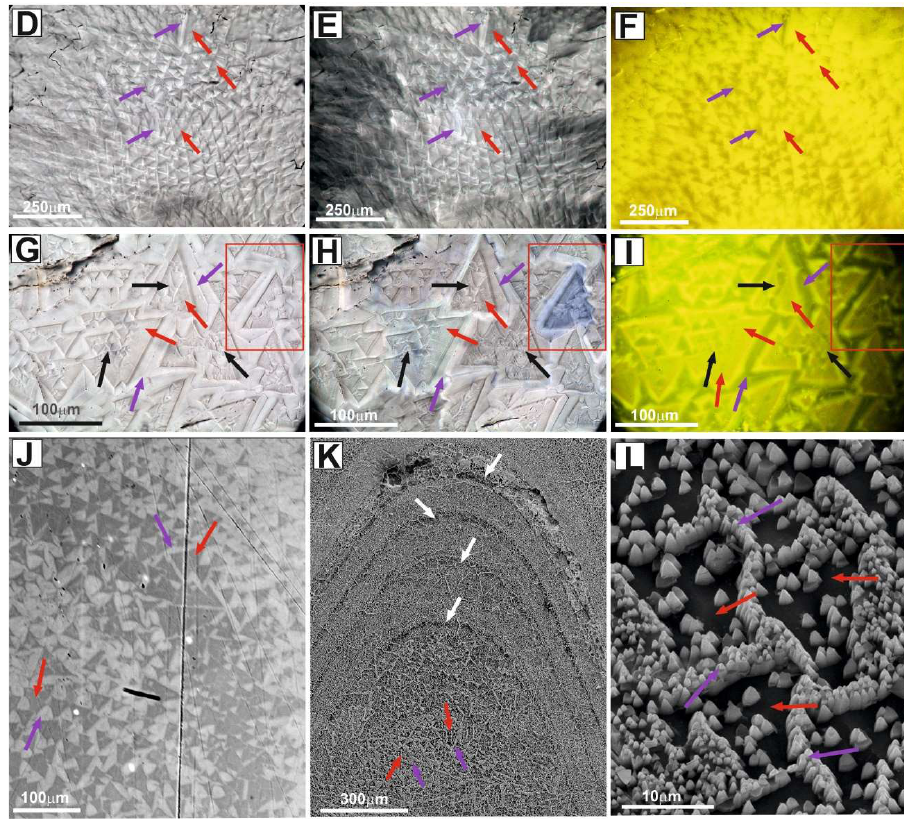
Figure 9. Photographs showing the composite nature of calcite crystals in belemnite rostra, which is observed in longitudinal sections that do not cross-cut the rostrum along the apical line. ( A – C ) TL ( A ), PL ( B ) and FL ( C ) photographs (specimen PC 31-4). In the central area, calcite crystals are cut perpendicularly to their c-axis and they are observed as an equigranular mosaic of crystals. Outwards, towards the external wall, crystals are cut tangentially to their c-axis and become elongated. Note also that the concentric layering is enhanced under FL microscopy and that layers become thinner towards the external walls. ( D – F ) Detailed images of ( A – C ). Note the triangular shape of crystals that comprise sectors displaying relatively low optical relief ( D , E ) and intense FL ( F ) (red arrows) and sectors displaying relatively high optical relief ( D , E ) and none-to-weak FL ( F ) (purple arrows). ( G – I ) Detailed photographs showing the composite nature of calcite crystals under TL ( G ), PL ( H ) and FL ( I ) microscopy (specimen PC-11-31). Triangular-shaped crystals comprise an inner sector (red arrows), which displays an overall relatively low optical relief ( D , E ), intense FL ( F ) and an internal “patchy” appearance (black arrows). Note that the “patches” also displays a triangular shape and higher optical relief than the surrounding calcite. The outer sector of the crystals (purple arrows), which is in optical continuity with the inner sector (red square in ( H )), displays relatively high optical relief ( D , E ) and non-to weak FL ( F ). Note the crystal boundaries (purple arrows and red square in ( G ) and ( H )). Note also that the triangular “patches” of the inner sector has an identical optical relief and FL than the outer sector of the crystals. ( J ) Same thin section as in ( A – F ), observed under BSEM. The triangular inner sectors of the crystal displaying intense FL are dark-grey in colour (red arrows), and the outer sectors of the crystals, displaying non-to weak FL, are light-grey in colour (purple arrows). ( K , L ). Same thin section as in ( A – G ), observed under BSEM after etching with 25% glutardialdehyde. Note that the triangular shape of crystals and the concentric layering (white arrows in ( K )) is enhanced under etching. The triangular areas comprise an inner sector, which has been largely etched (red arrows), and an outer sector where dissolution is less pervasive (purple arrows). The largely etched concentric layers, which would correspond to the intense FL concentric layers, are thin (white arrows) compared to those where etching is less pervasive.